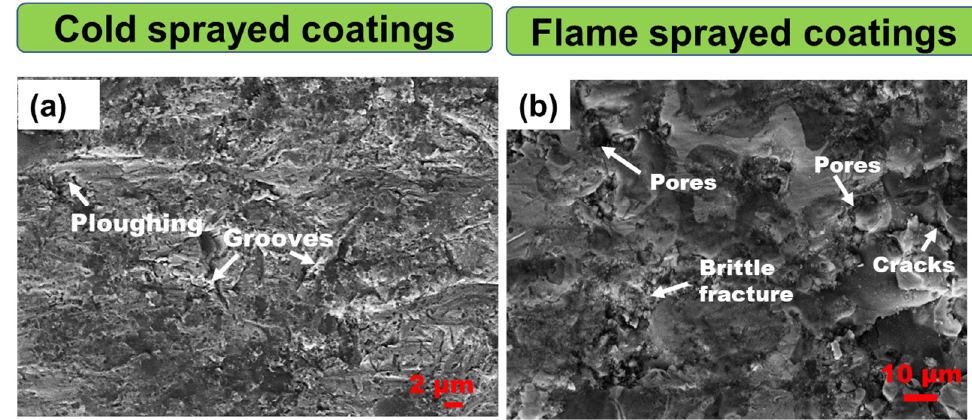
Figure 14. Backscattered SEM images of ( a ) cold-sprayed and ( b ) flame-sprayed AlCoCrFeMo HEA coatings [59].